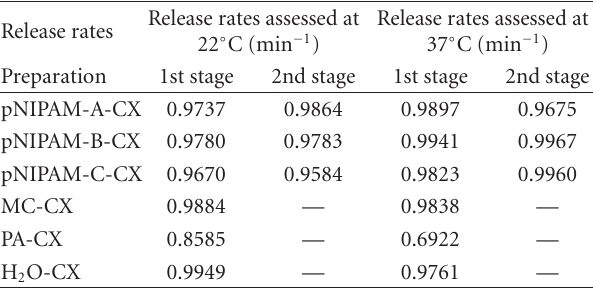
Figure 6: Influence of the type of polymer on the release kinetics of CX from the polymeric bead at 37 ◦ C. The release from respective preparations was depicted as follows: pNIPAM-A-CX for first stage ( (cid:2) ) and second stage ( ♦ ), pNIPAM-B-CX for first stage ( (cid:3) ) and second stage ( (cid:6) ), pNIPAM-C-CX for first stage ( (cid:4) ) and second stage ( (cid:7) ), MC-CX ( ◦ ), PA-CX ( × ), and aqueous dispersion of CX (+), data from repeated six